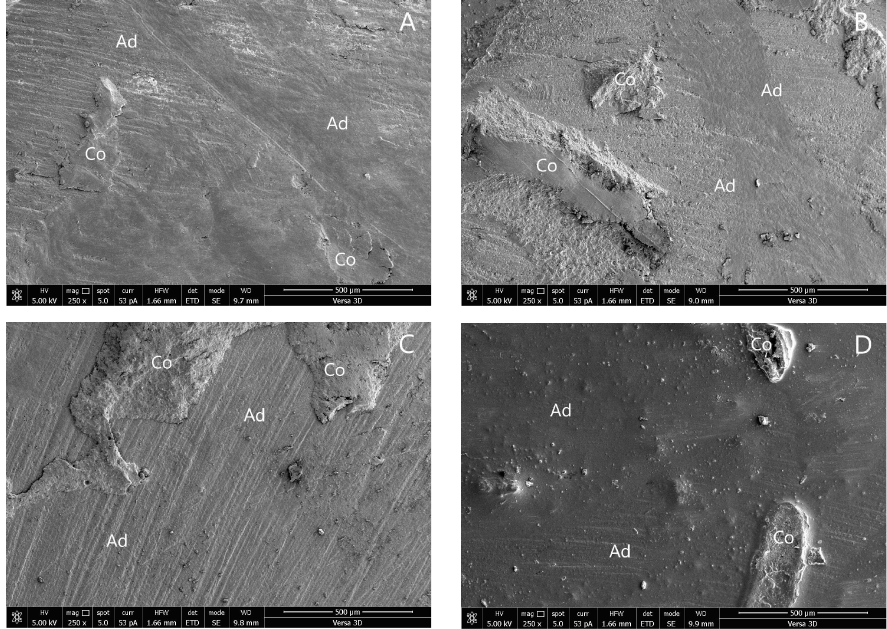
Figure 4. SEM photographs of mixed failure mode: ( A ) group 2; ( B ) group 3; ( C ) group 7; and ( D ) group 9. (Ad, adhesive failure; Co, cohesive failure in new resin